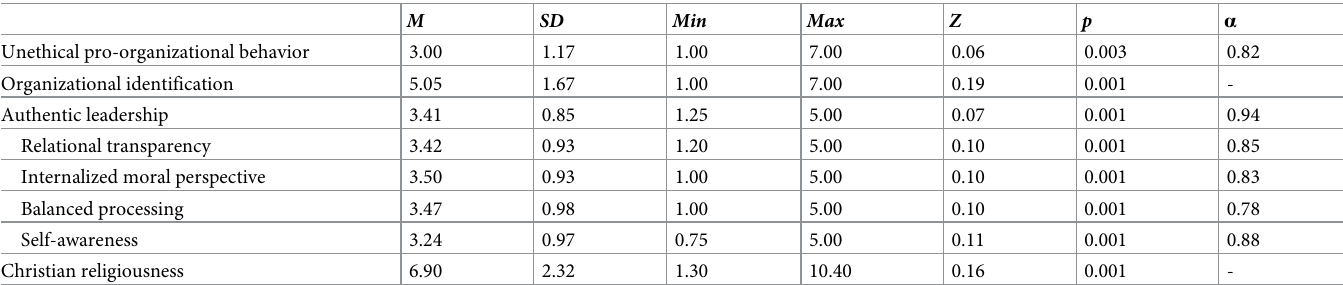
Table 6. Descriptive statistics of the variables under